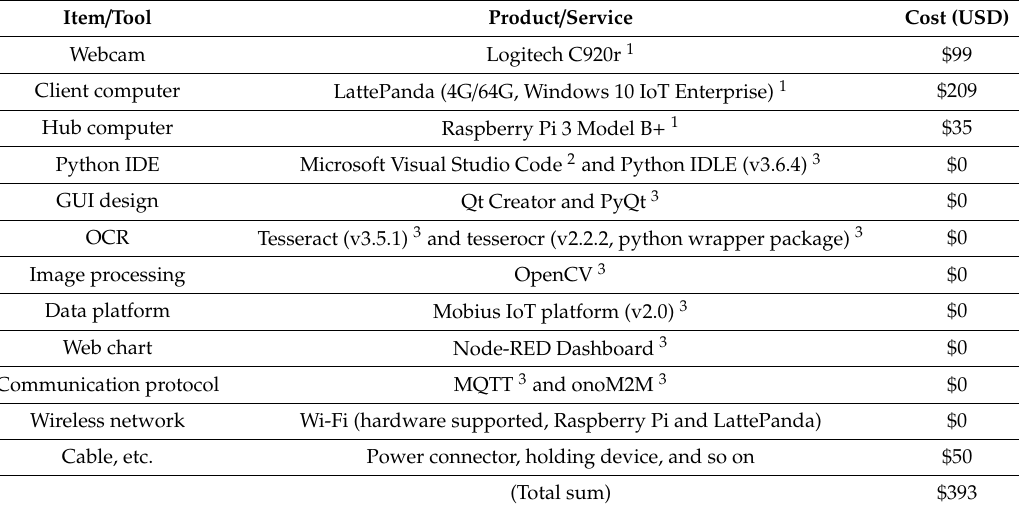
Table 5. Direct costs of the prototype